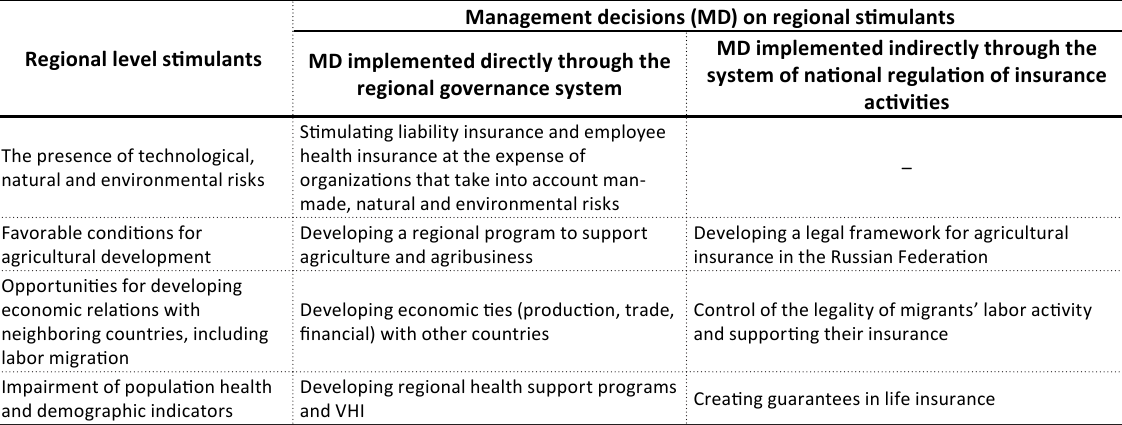
Table 7. Managing regional stimulants affecting the RIM development in